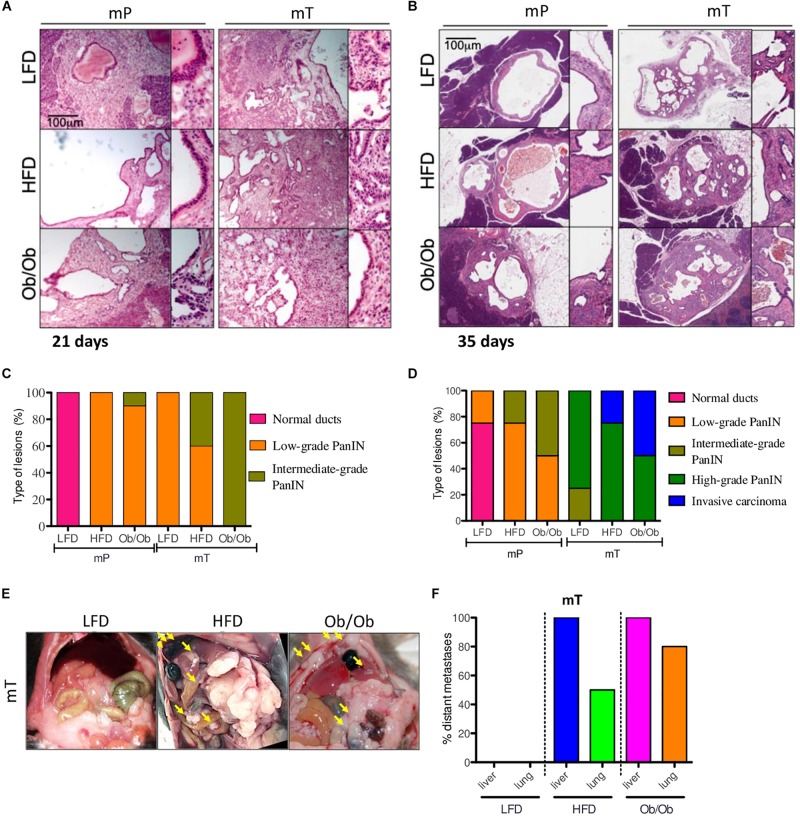
Obesity accelerated the carcinogenesis and growth of both mP and mT pancreatic organoid models. Representative micrographs of pancreatic cysts of ob/ob, HFD and LFD mice bearing mP and mT organoid models. Hematoxylin & eosin staining, original magnifications: 100x and 200x, scale bar 100 μm; The H&E stained slides of the pancreatic tissue excised (A) at 21 days and (B) 35 days. Each lesion was reviewed by a pathologist and a score of progression assigned (normal stratification of ducts; to invasive carcinoma (C,D); (E) Representative images of peritoneal metastasis in the mT organoid bearing mice (groups: mT_LFD = 3; mT_HFD = 3; mT_ob/ob = 2); (F) Quantification of retro-peritoneal metastasis in the mT organoid bearing mice (groups: mT_LFD = 3; mT_HFD = 3; mT_ob/ob = 2). Data are shown as the percentage of mice with metastases in the indicated site. The picture reported the percentage of mice presenting with at least one metastasis in indicated organs.